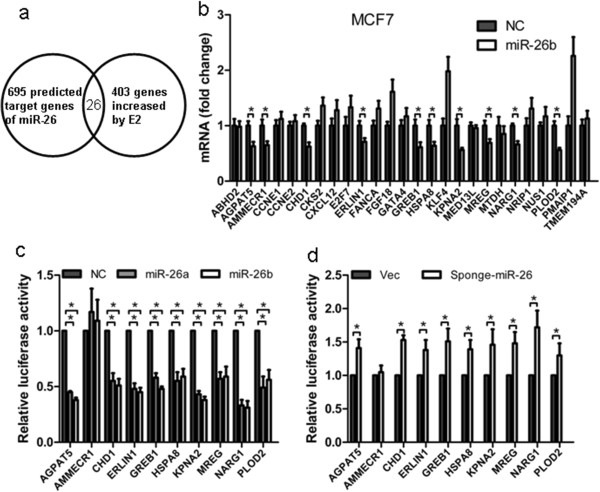
Regulation of gene expression by miR-26. (a) Venn diagram showing the number of genes identified by prediction methods compared with differential expression in 17β-estradiol (E2)-treated MCF-7 cells. (b) Ectopic expression of miR-26b in MCF-7 cells decreased mRNA levels of the indicated 10 genes by quantitative real-time polymerase chain reaction. Glyceraldehyde 3-phosphate dehydrogenase was used as an internal control. (c) Luciferase reporter assays in T47D cells, with co-transfection of the wild-type 3′ utranslated region (UTR) and miRNA as indicated. (d) Luciferase reporter assays in T47D cells, with co-transfection of wild-type 3′ UTR and miRNA sponge as indicated. *P < 0.05. **P < 0.01.